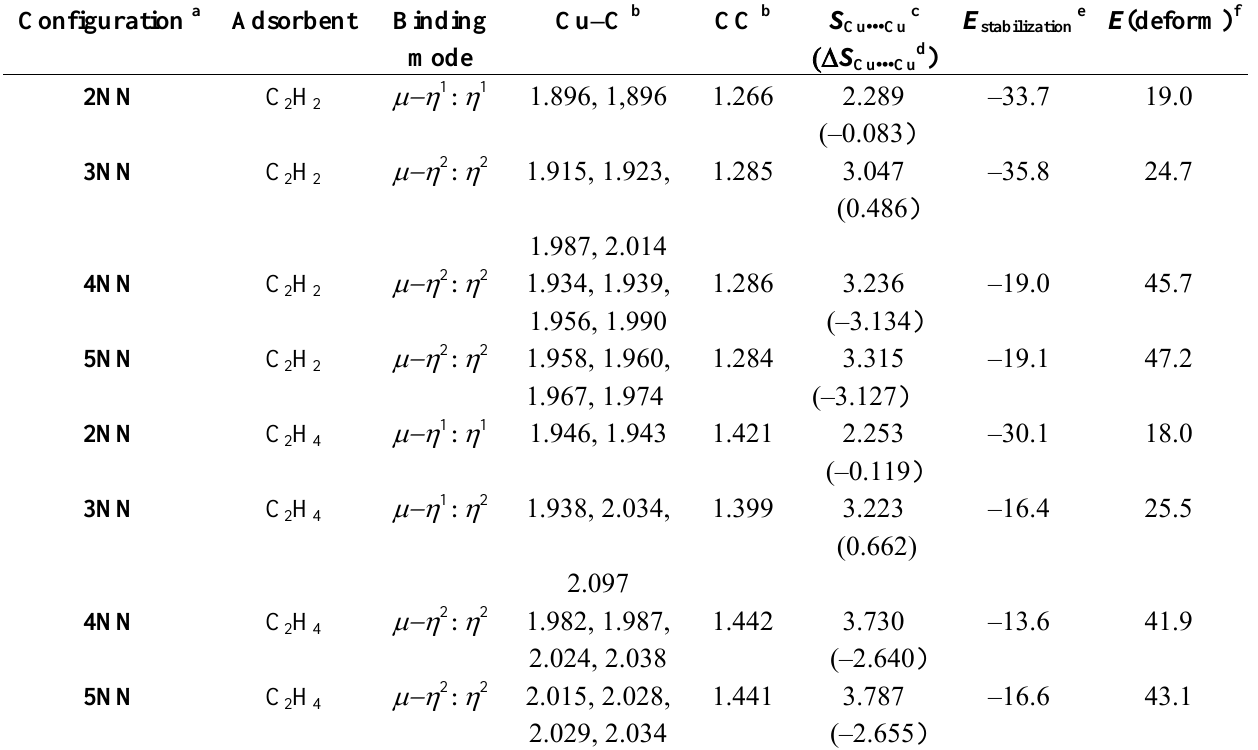
Table 8. Key parameters of the optimized structures of an unsaturated hydrocarbon adsorbed onto a dicopper active center embedded inside a realistic ZSM-5